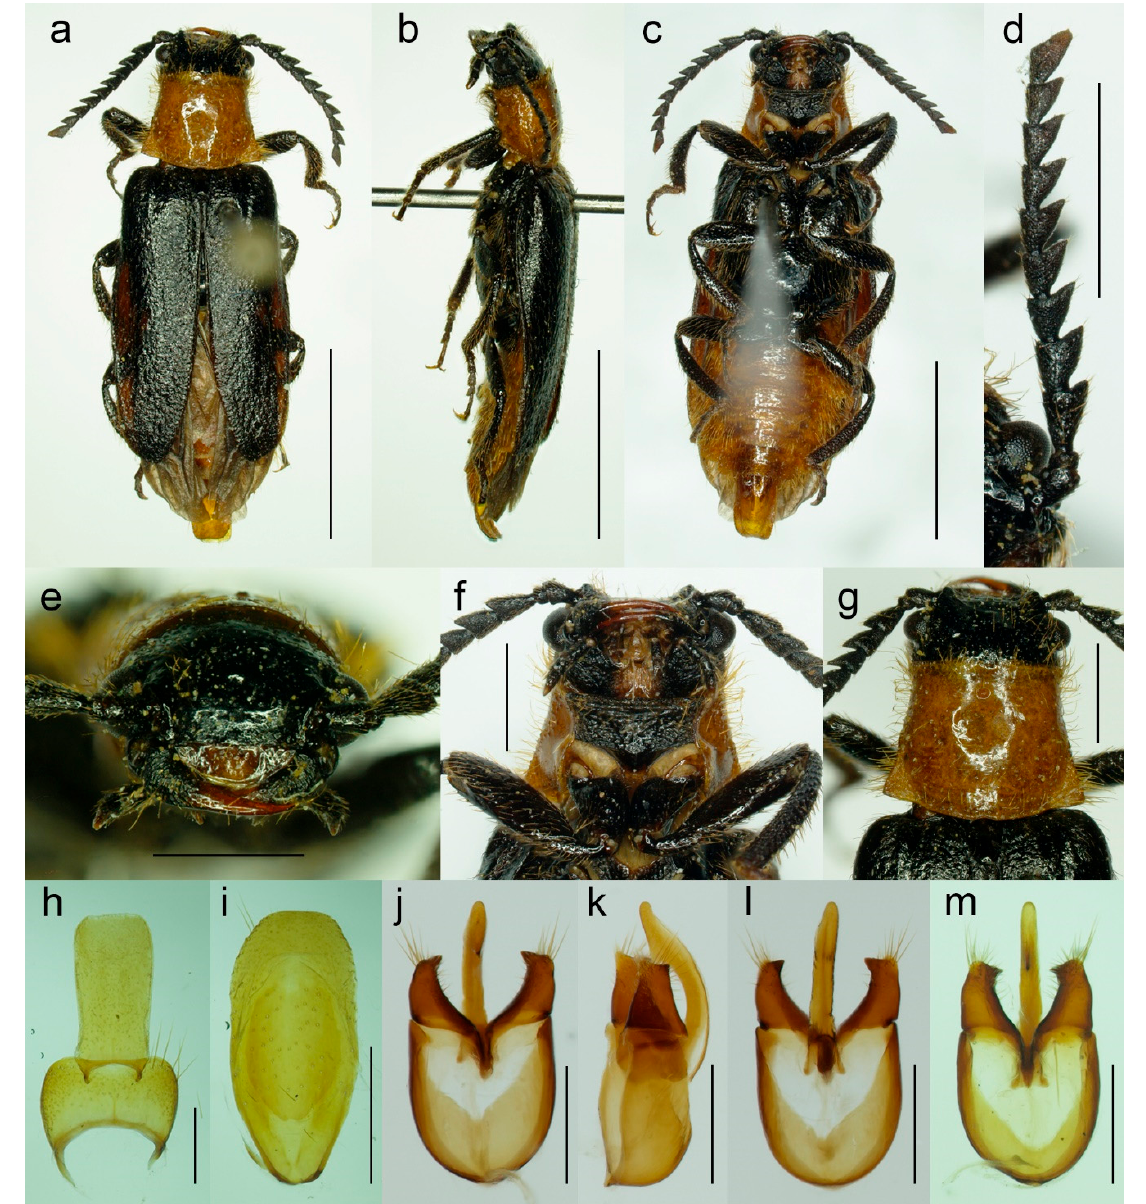
Figure 12. Malacogaster nigripes Schaufuss, 1867, male. Specimen from Altea, Spain. ( a ) Habitus, dorsal view; ( b ) habitus, lateral view; ( c ) habitus, ventral view; ( d ) left antenna; ( e ) head, frontal view; ( f ) head, ventral view; ( g ) pronotum, dorsal view. Specimen from Alcossebre, Spain. ( h ) abdominal tergites IX and X, dorsal view; ( i ) abdominal sternite IX, ventral view. Specimen from Altea, Spain. ( j ) Aedeagus, dorsal view; ( k ) aedeagus, lateral view; ( l ) aedeagus, ventral view. Specimen from Alcossebre, Spain. ( m ) Aedeagus, dorsal view. Scale bars = ( a – c ) 3.5 mm; ( d ) 1.5 mm; ( e – g , i ) 1.0 mm; ( h , j – m ) 0.5 mm.